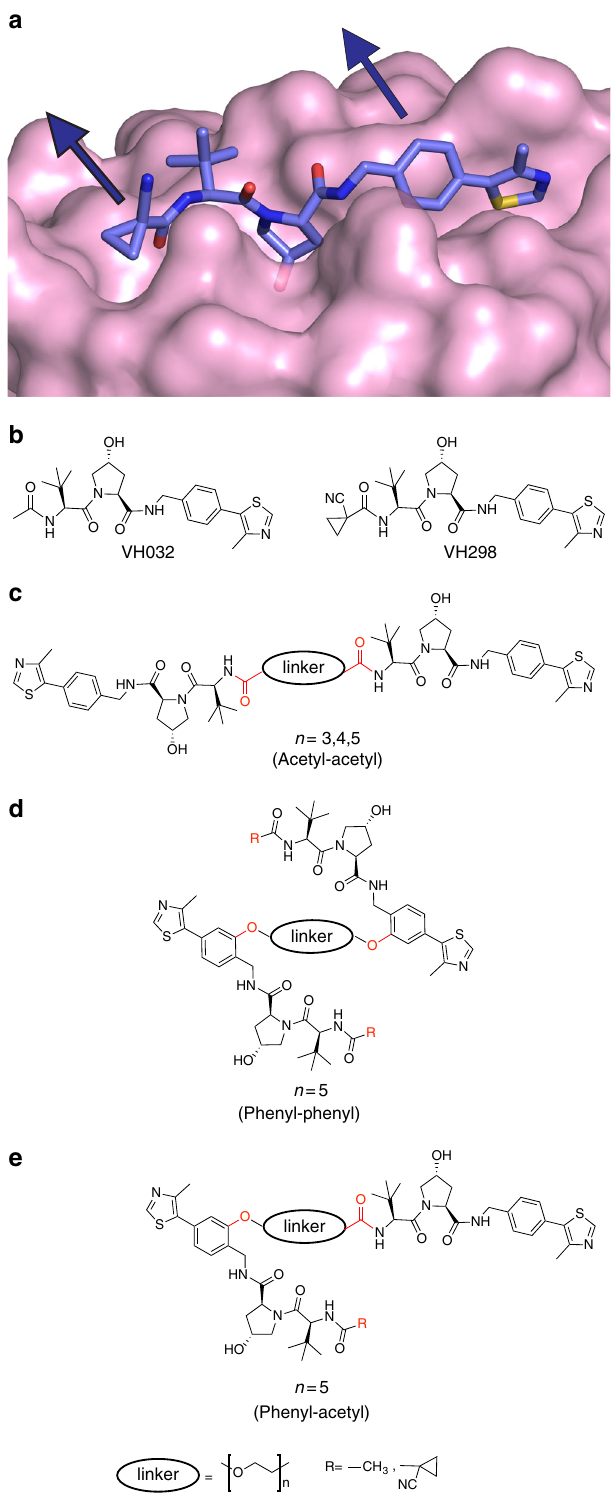
Fig. 1 Structure-guided design of Homo-PROTACs to induce VHL dimerization. a Crystal structures of VHL in complex with VH298 (PDB code 5LLI) 19 . VHL is shown as a pink surface and the bound ligand as sticks representation with purple carbons, nitrogen atoms in blue, oxygen in red and sulphur in dark yellow. b Chemical structure of VHL inhibitors VH032 and VH298. c – e General chemical structures and design of Homo- PROTACs compounds. Linkage sites at the acetyl and phenyl groups are indicated in